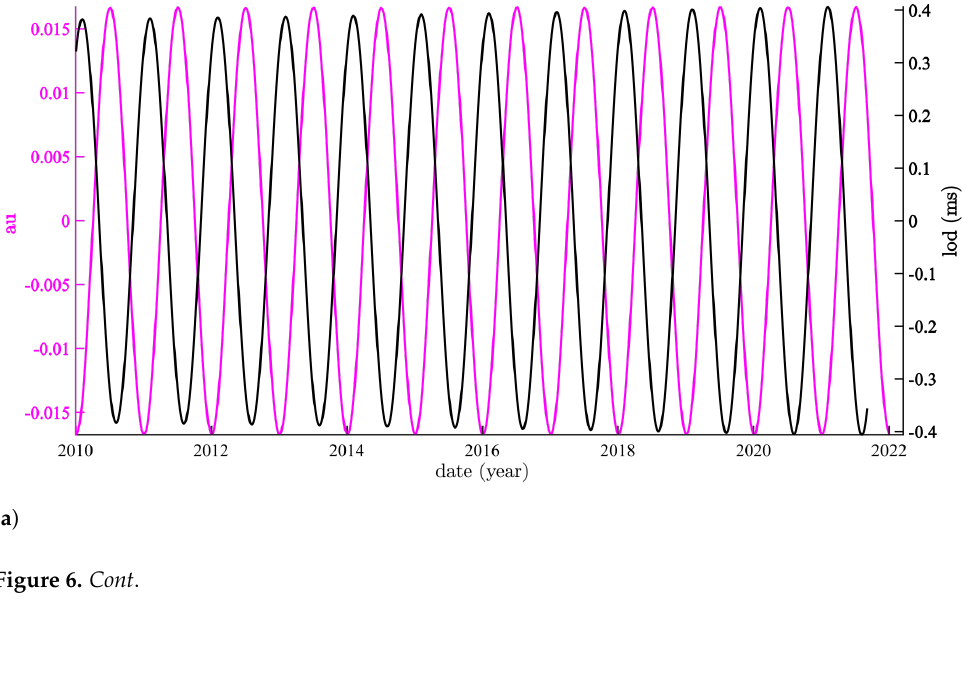
Figure 6. Variations in the Earth-to-Sun distance D SE (in au; purple) compared to the first (annual) SSA component of m 1 ( bottom ) and the lod ( top ). In the middle curve, lod is offset by 152.5 days.